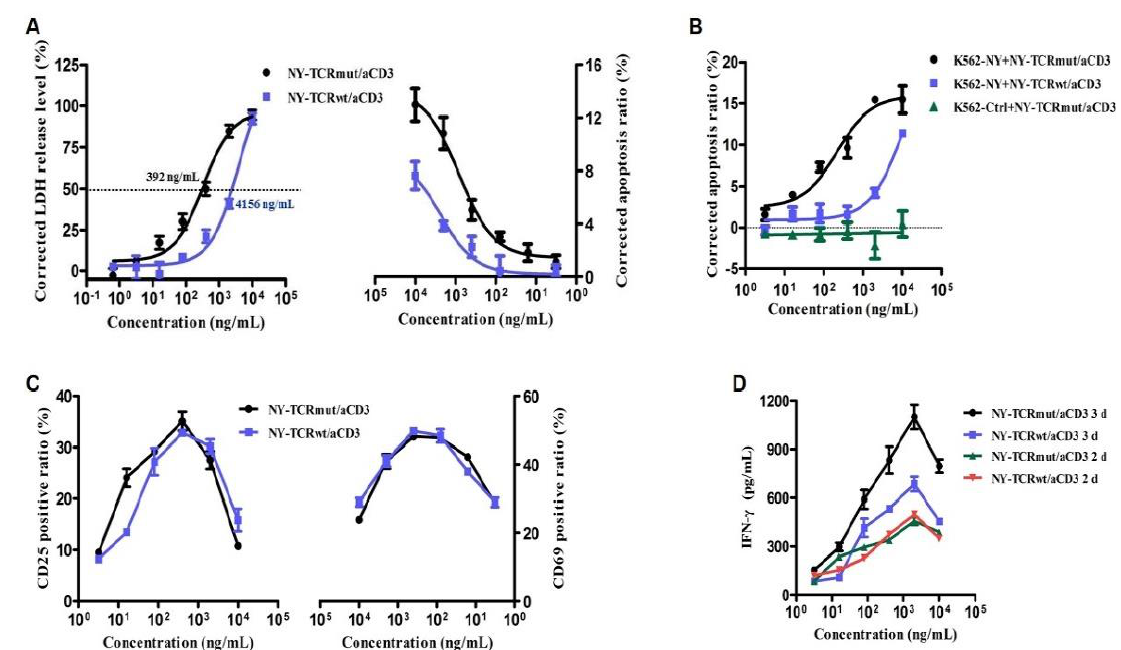
Figure 3. NY-TCR/aCD3 activated and redirected naïve T cells to specifically kill NY/A02 + tumor cells. ( A ) Lysis of A375 or A375-eGFP cells over 48 h using PBMC in the presence of titrated concentrations of NY-TCR/aCD3. The lysis was determined by cell apoptosis assay (n = 3, right) or LDH release assay (n = 3, left). ( B ) Lysis of K562-based tumor cells over 48 h using PBMC in the presence of titrated concentrations of NY-TCR/aCD3 (n = 3). The lysis was determined by cell apoptosis assay. ( C ) T cell activations were marked as CD69 + or CD25 + after treatment with NY-TCR/aCD3 for 72 h (n = 3). CD69 + and CD25 + T cells significantly increased with different concentrations of NY-TCR/aCD3, but the increased amplitude decreased with high concentrations of NY-TCR/aCD3. ( D ) T cell activations were showed using IFN- γ assay (n = 3). IFN- γ secretion significantly increased in a time-dependent manner with different concentrations of NY-TCR/aCD3, but it decreased at 10 µ g/mL, and NY-TCRmut/aCD3 was able to induce more IFN- γ secretion than NY-TCRwt/aCD3 in 72 h. Data are means ±